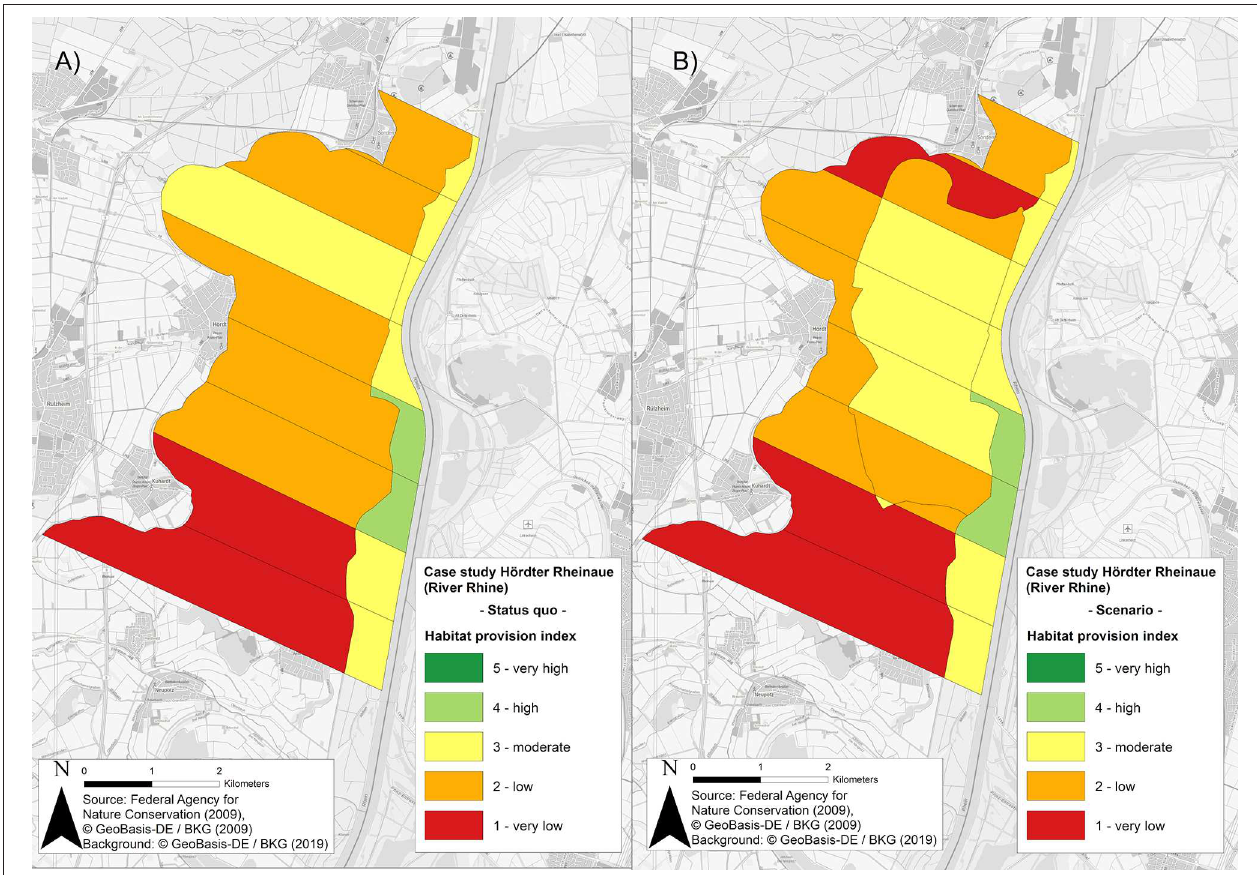
FIGURE 4 | Assessment of the ecosystem service habitat provision according to the developed index showing (A) status quo and (B) polder scenario at the Hördter Rheinaue (River Rhine) separated into active and former floodplain compartments (see Figure 1C ). Habitat provision index classes: 1, very low; 2, low; 3, medium; 4, high; 5, very